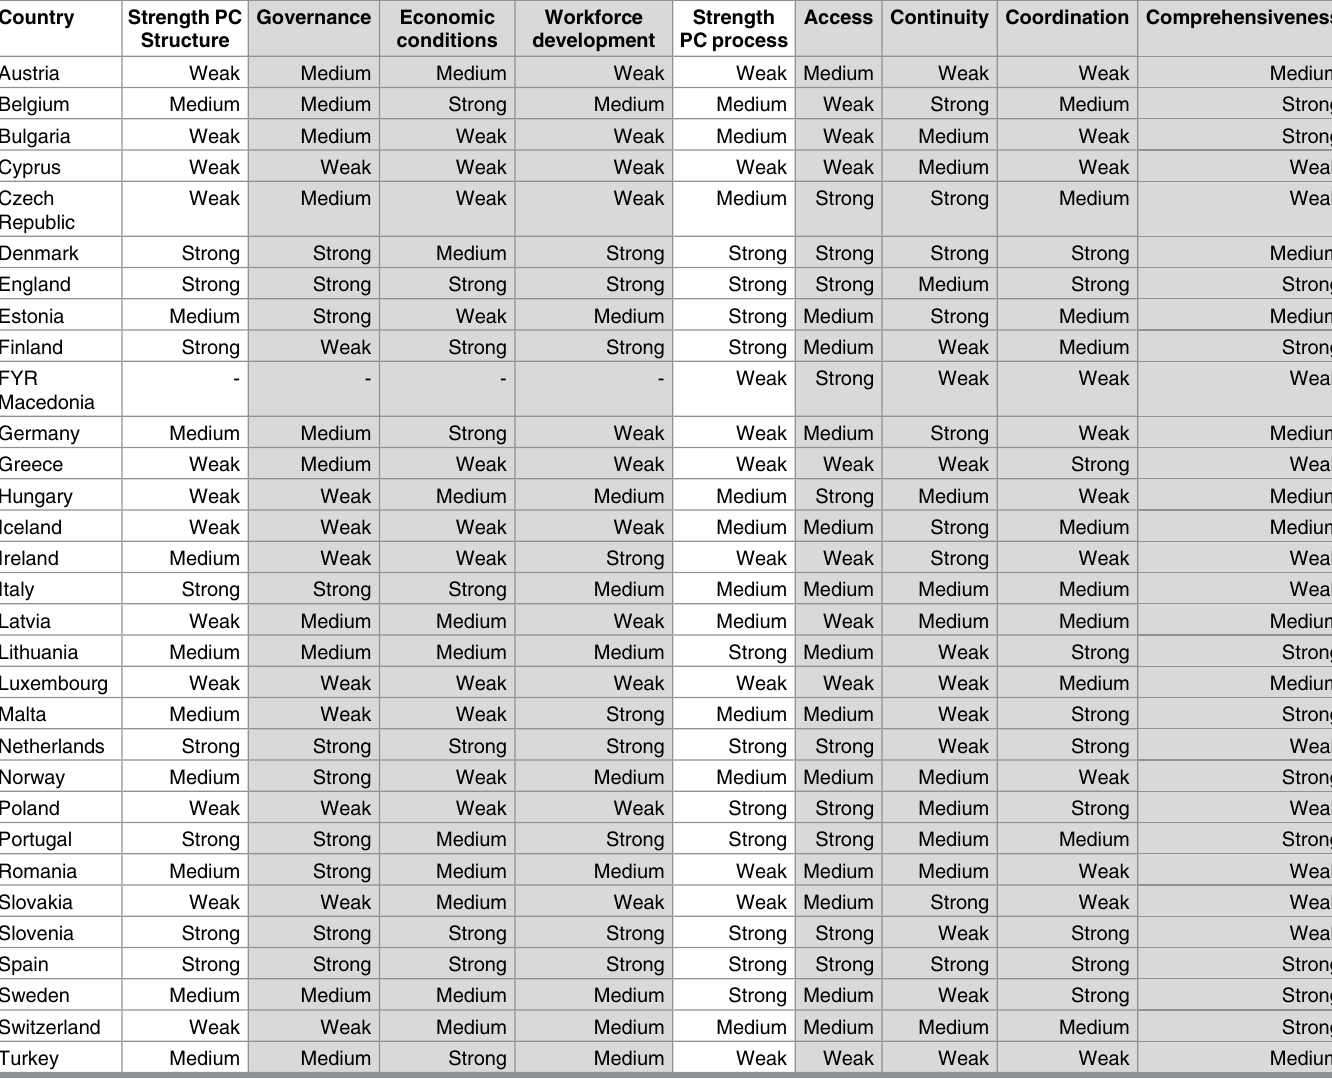
Table 2. Overview of the country characteristics in relation to healthcare systemfeatures: structure and process strength.